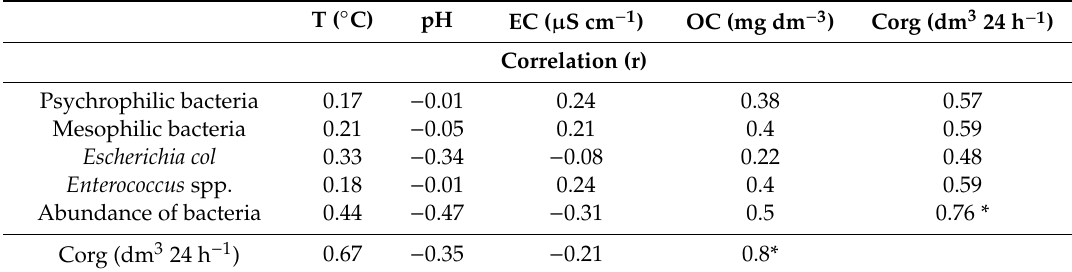
Table 4. Correlations between physico-chemical and biological parameters of water and the number of analyzed group of bacteria.